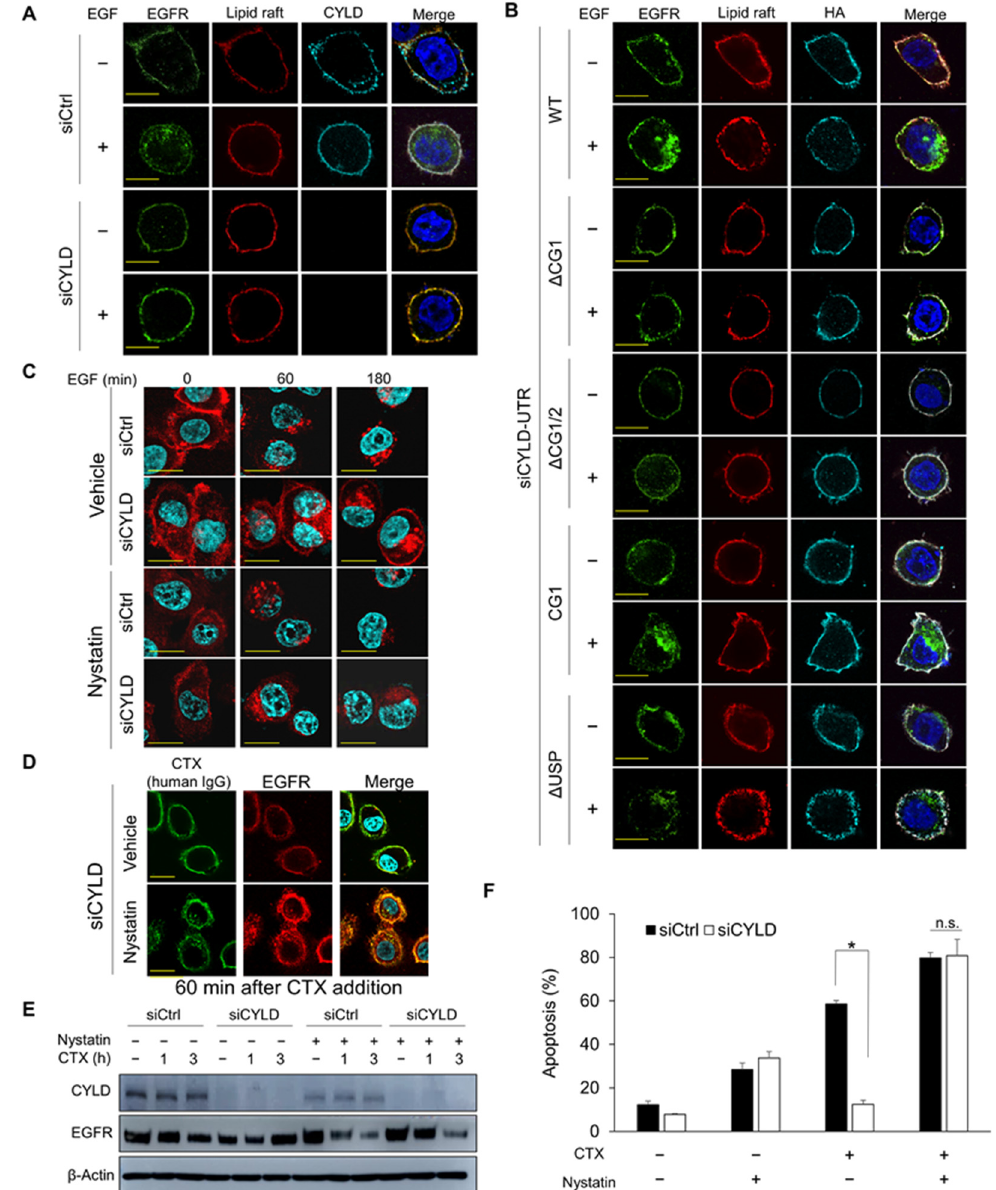
Figure 5. Effect of cholesterol depletion on CYLD-downregulated cells. ( A , B ) Localization of EGFR, lipid rafts, and CYLD ( A ) or anti-hemagglutinin (HA) ( B ) as analysed by immunofluorescence staining. HSC3 cells were transfected with the indicated siRNA and plasmids expressing deletion constructs of CYLD. After incubation for 48 h, cells were starved for 12 h in a serum-free medium. Cells were then stained with the appropriate antibodies and observed under fluorescent microscopy. Scale bars, 10 µm. ( C , D ) Effects of nystatin on EGF- or cetuximab (CTX)-induced EGFR endocytosis. HSC3 cells were transfected with siRNA and incubated for 48 h, then, after 12 h of incubation in a serum-free medium, cells were pretreated with 25 µg/mL of nystatin for 30 min before stimulation with 100 ng/mL of EGF for the indicated times ( C ) or 100 µg/mL of CTX for 60 min ( D ). EGFR localization was analysed via immunofluorescence staining. Scale bars, 20 µm. ( E ) Effects of nystatin on total EGFR expression after CTX treatment in CYLD-downregulated cells. HSC3 cells were transfected with siRNA and were then incubated for 48 h. Cells were pretreated with 25 µg/mL of nystatin for 30 min before treatment with 100 µg/mL of CTX for the indicated times. Total EGFR protein expression was analysed via Western blotting. CHX was added 1 h before nystatin treatment. ( F ) Effects of nystatin on CTX-induced apoptosis. HSC3 cells were transfected with siRNA and then incubated for 48 h. Cells were pretreated with 25 µg/mL of nystatin for 30 min before treatment with